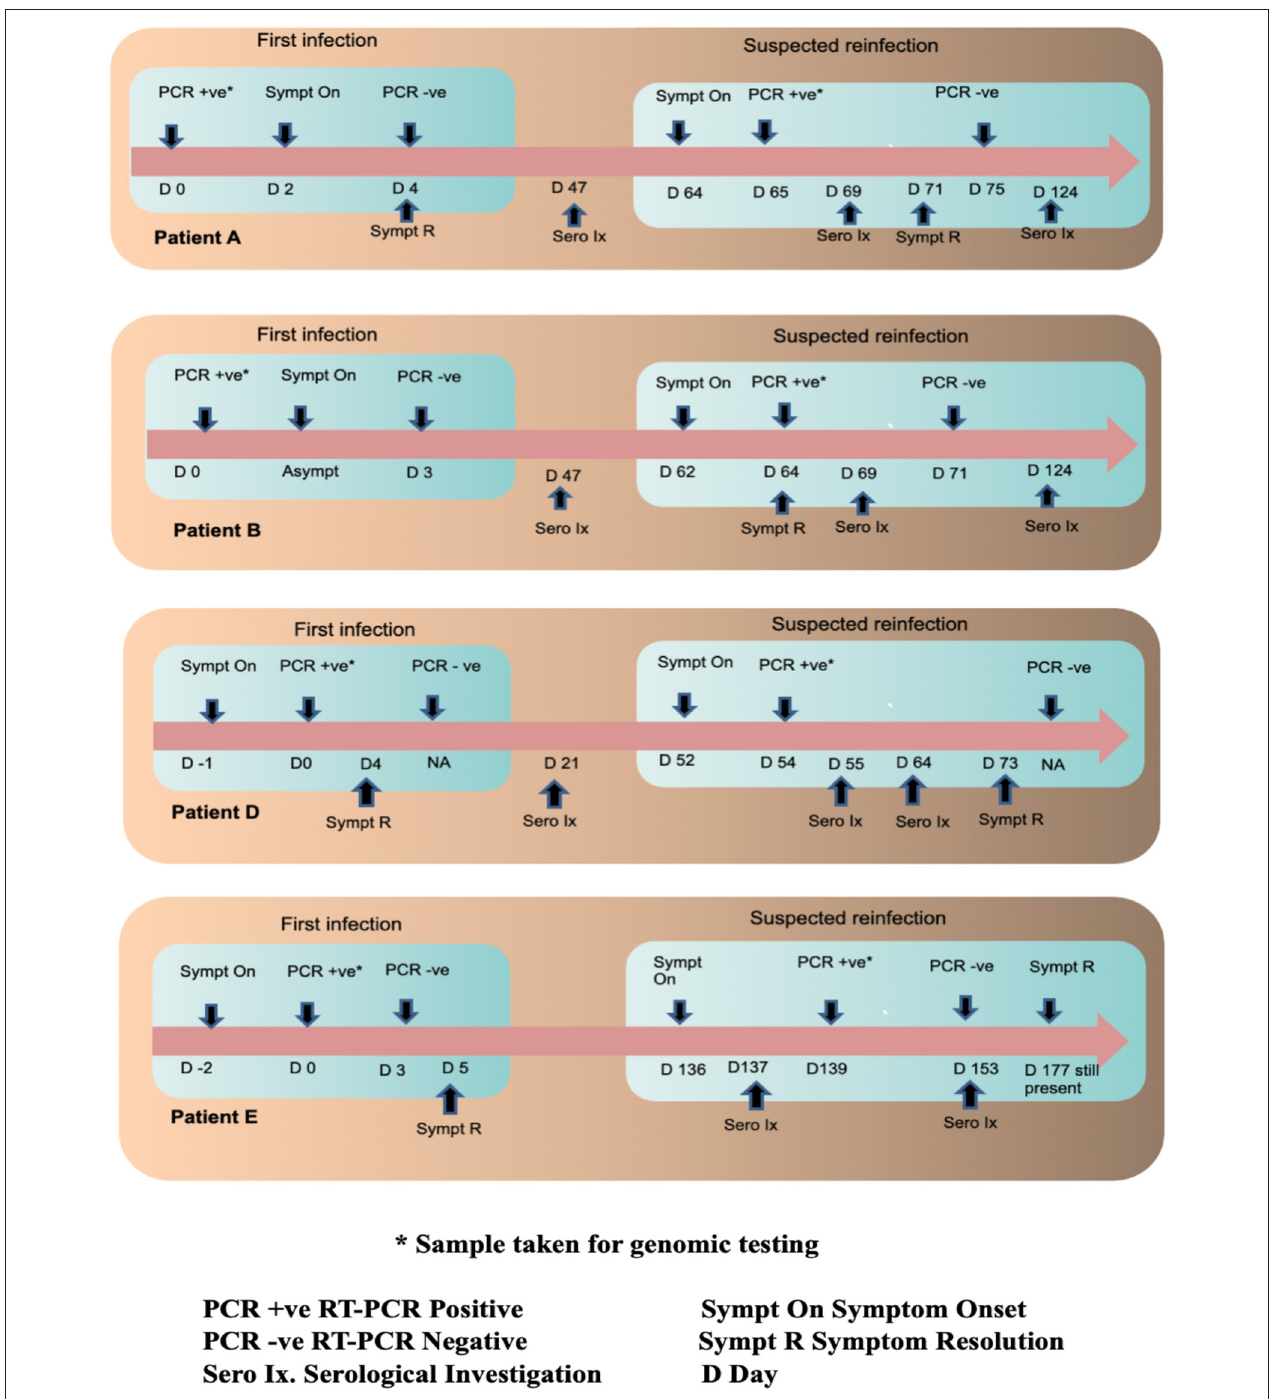
FIGURE 1 | Timeline of infections in the four patients along with their serological and RT PCR investigations.